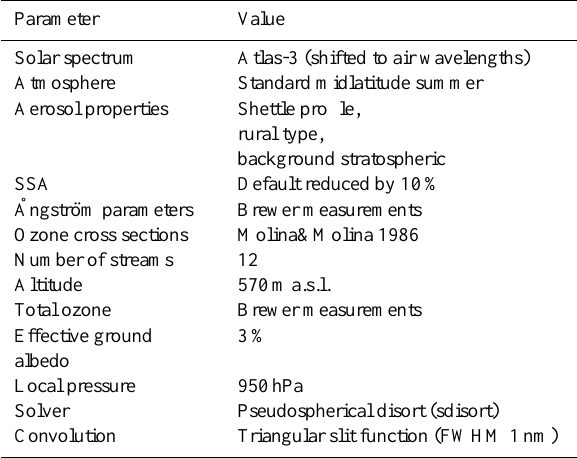
Table 5. Input parameters to the radiative transfer